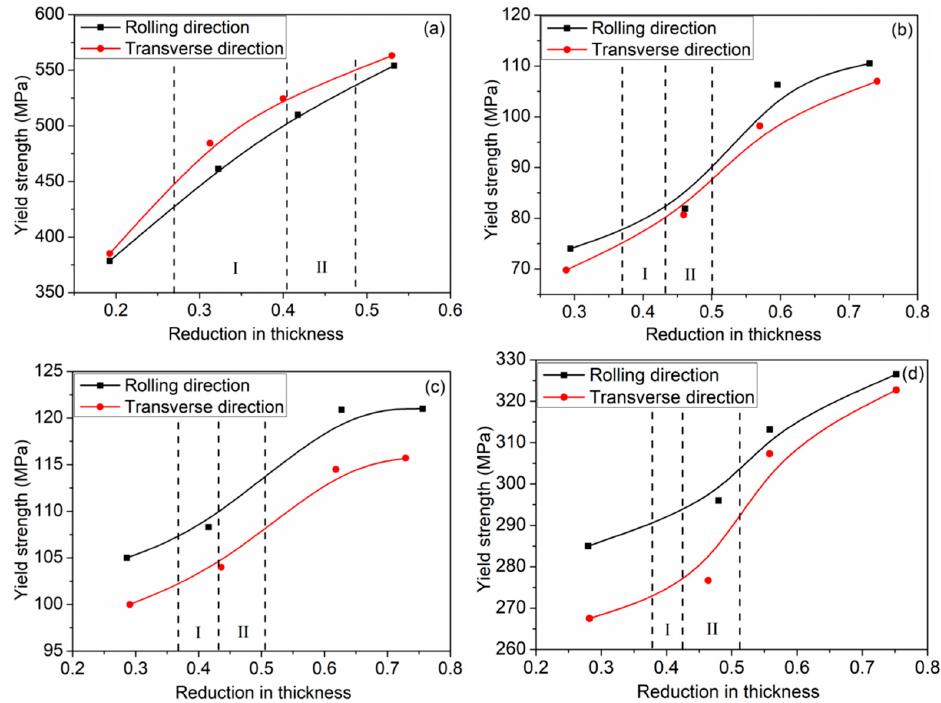
Figure 6. Relationship between tensile yield stress and reduction. ( a ) TA1; ( b ) Al ① ; ( c ) Al ② ; ( d ) Al ③ .